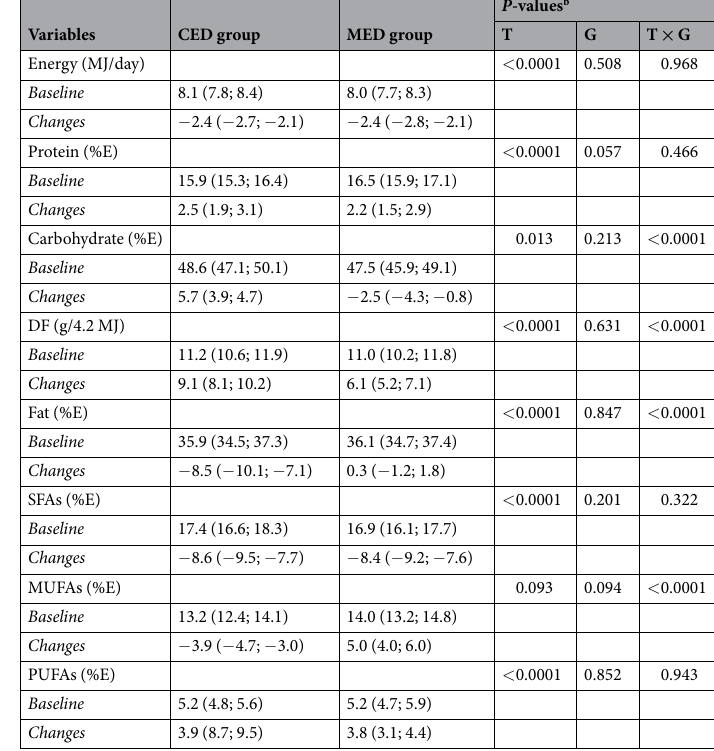
Table 3. Dietary intake characteristics in the CED and MED groups a . Abbreviations: DF: Dietary fiber; MUFAs: monounsaturated fatty acids; SFAs: saturated fatty acids; PUFAs: polyunsaturated fatty acids; T: time; G: group; T × G: time–group interaction; a Values are expressed as means (95% CI); b Linear mixed model for values at each time point, significant at P < 0.05; CED: baseline: n = 72; week 4: n = 70; week 8: 68; week 12: n = 65; week 16: n = 63; MED: baseline: n = 72; week 4: n = 72; week 8: 72; week 12: n = 70; week 16: n = 67; in the table values at baseline and changes from baseline to the average of the four postrandomization time points are